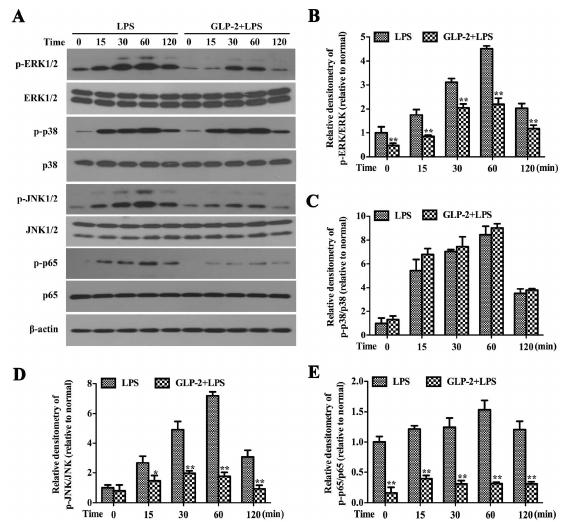
Figure 6. Effects of GLP-2 on LPS-induced activation of MAPKs and NF- κ B in BV-2 cells. BV-2 cells were pretreated with GLP-2 (10 ´ 6 M) for 1 h followed by the treatment of LPS (1 µ g/mL) for 0, 15, 30,